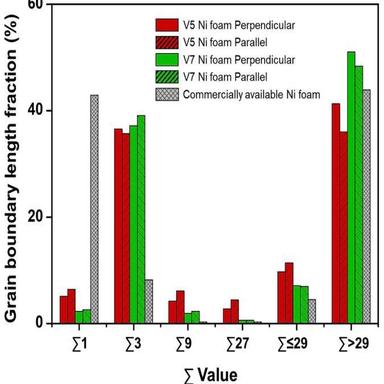
Grain boundary length fractions of Σ-boundaries in Ni foams fabricated by freeze casting NiO slurry containing 5 vol% and 7 vol% NiO powder, and commercially available Ni foam.